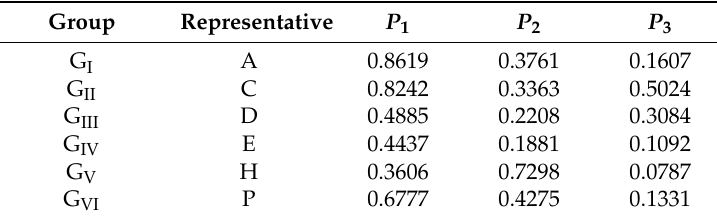
Table 3. The values for properties of the six